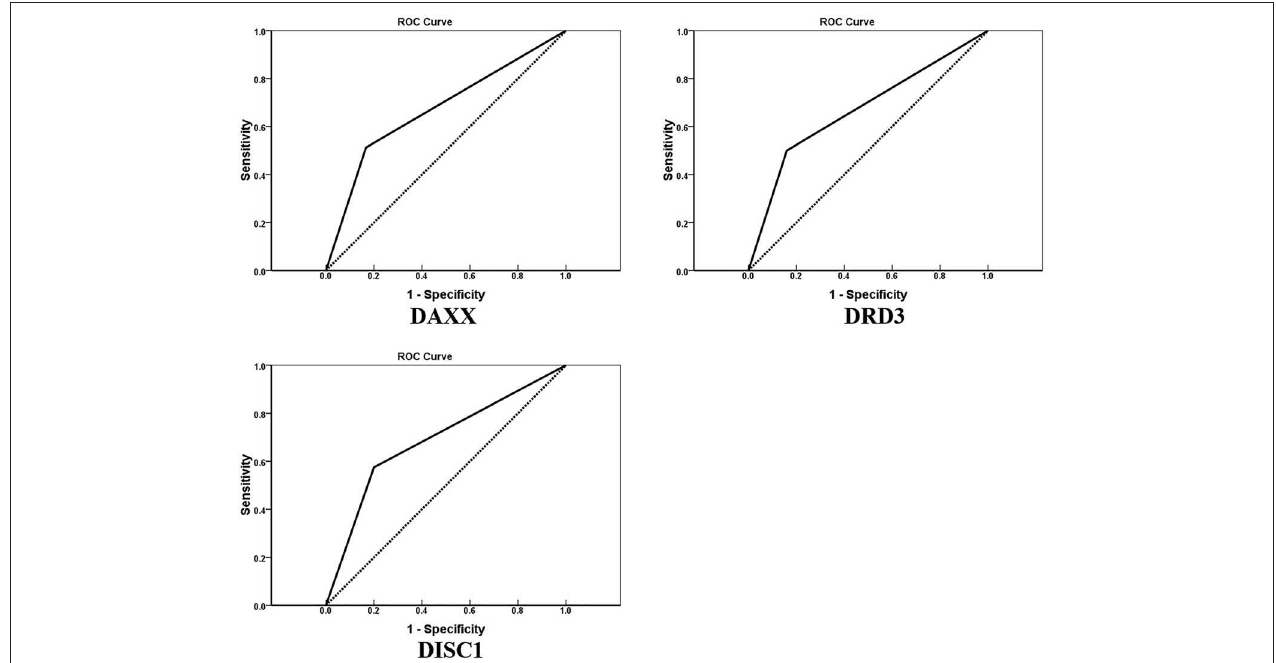
FIGURE 3 | Receiver operating characteristic curves for DAXX, DRD3, and DISC1 protein expression in 80 patients with chondrosarcoma (January 2011–June 2015). Areas under the curves are 0.673, 0.670, and 0.688,